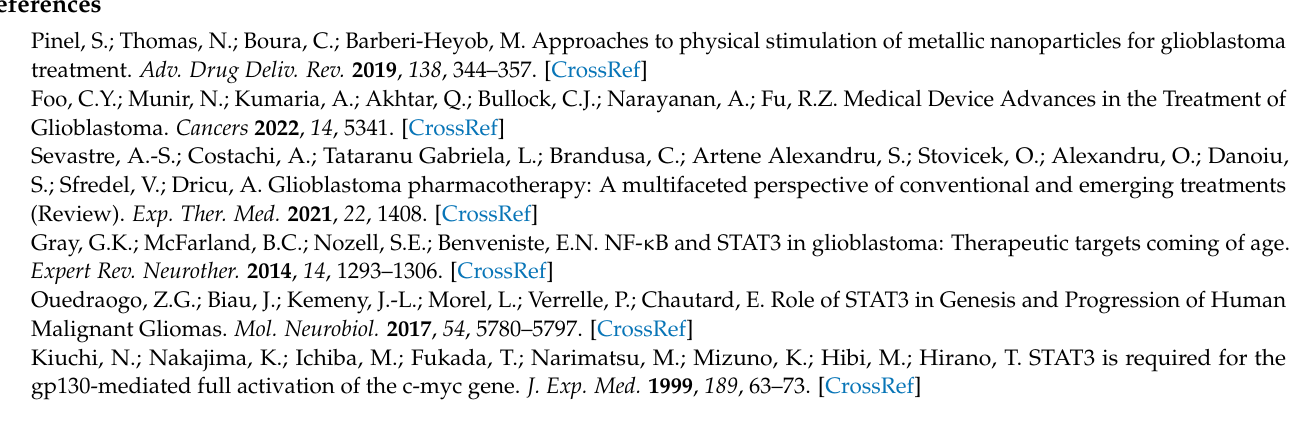
Figure S2. Spectrofluorimetry calibration curve; Figure S3. Linear regression of RUX using HPLC analysis; Figure S4. UV spectrum of RUX; Figure S5. Illustration of the semi-automated custom-made system for diffusion tests; Figure S6. Release profile of RUX from MIP 2 and MIP 4 in Franz cells; Figure S7. Phase contrast microscopy images taken at 24 h with 10X objective; Figure S8. Phase contrast microscopy images taken at 48 h with 10X objective; Figure S9. Phase contrast microscopy images taken at 96 h with 10X objective; Table S1. Chromatographic data of the calibration set of standard RUX for regression analysis; Table S2. Drug release at pH = 7.4; Table S3. Drug release at pH =